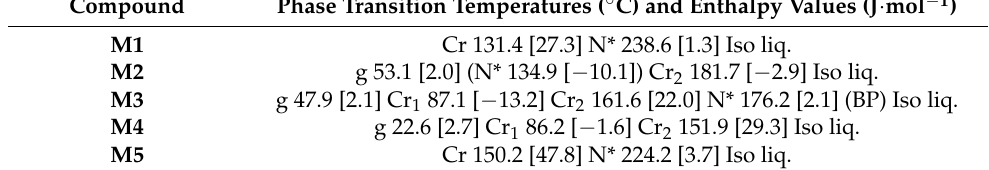
Table 2. Phase transition temperatures ( ◦ C) and corresponding enthalpy values (J mol − 1 , in square brackets) obtained from differential scanning calorimetry (DSC) second heating cycles for com- pounds M2–M5 .